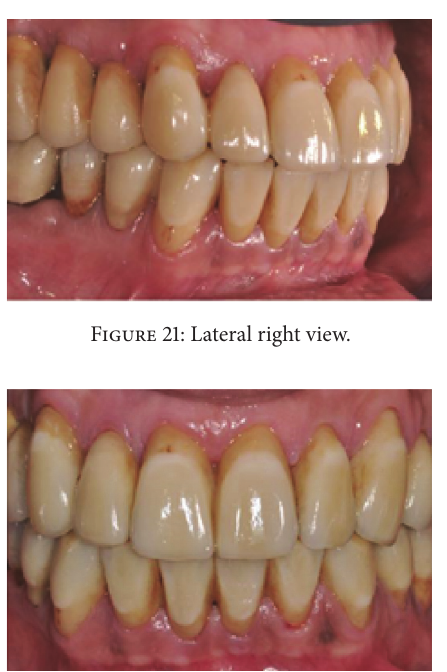
Figure 20: Final restorations, lateral left view.